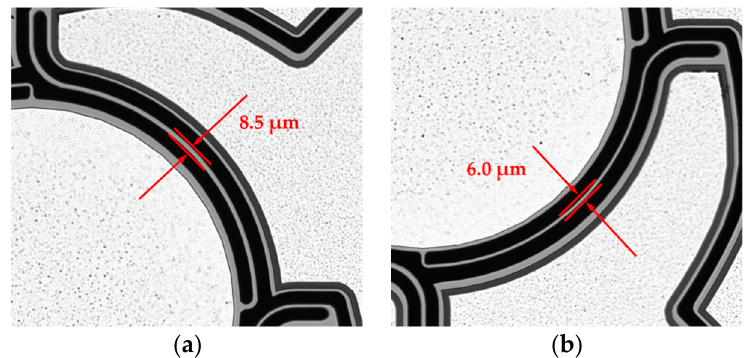
Figure 7. The fabrication process flow: ( a ) AlN deposition; ( b ) AlN wet etching; ( c ) Al deposition and structuring; ( d ) Backside Si etching by deep reactive ion etching (DRIE); ( e ) Device Si structuring.